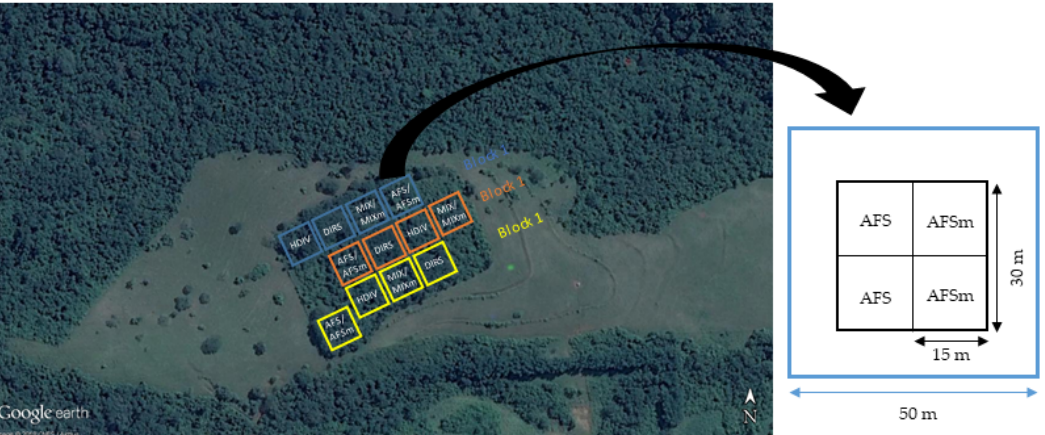
Figure 2. Experimental design at the Alfisol site: plots by treatment (50 × 50 m) and sampled subplots (15 × 15 m). Labels: MIXm (‘managed’ commercial mixed plantation), MIX (commercial mixed plantation), HDIV (high-diversity tree plantation), AFSm (‘managed’ agroforestry system), AFS (agroforestry system), DIRS (direct seeding). For HDIV and DIRS, two subplots were sampled, while in the (split) AFS and MIX plots, all four 15 × 15 subplots were